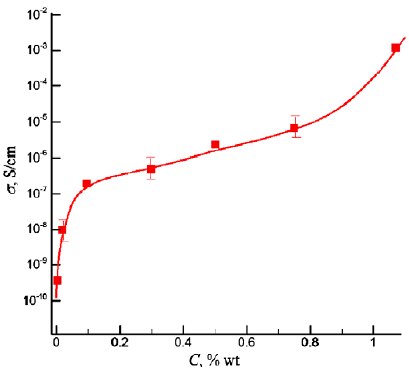
Figure 4. The electrical conductivity ( σ ) of a carbon nanotube-doped liquid crystal (LC-CNT) composite versus the weight fraction (wt.%) of carbon nanotubes (CNTs) [39].